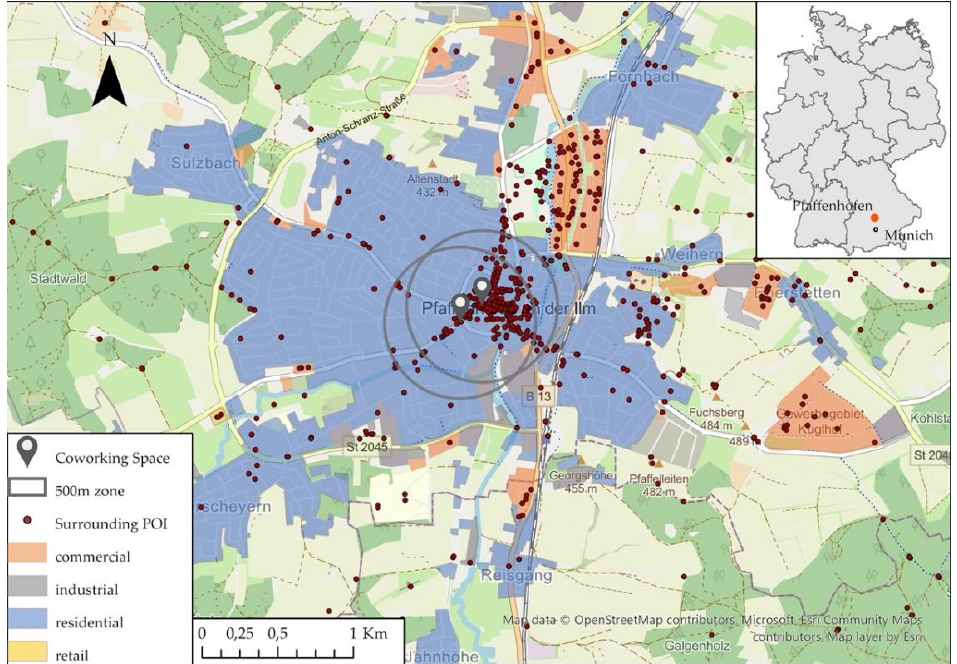
Figure 12. Map of all POIs of the category ’pois_free’ in Pfaffenhofen an der Ilm (without scale) source: ArcGIS ® software by Esri, OSM, gefabrik.de, coworkingmap.de, © GeoBasis-DE/BKG (2020).